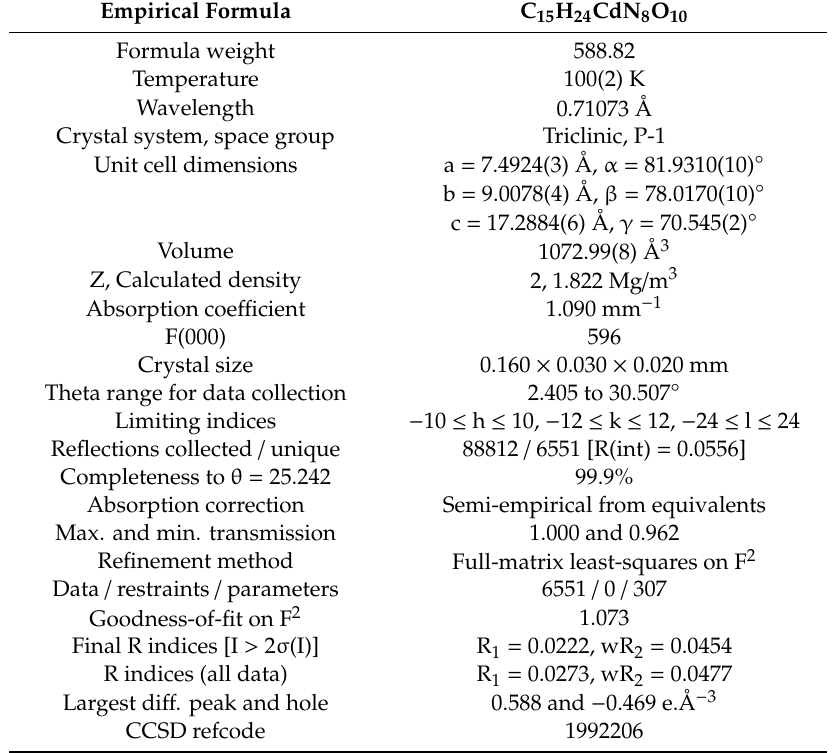
Table 1. Crystal data and structure refinement for H 2 (N3,N7)dap[Cd(HEDTA)(H 2 O)] · H 2